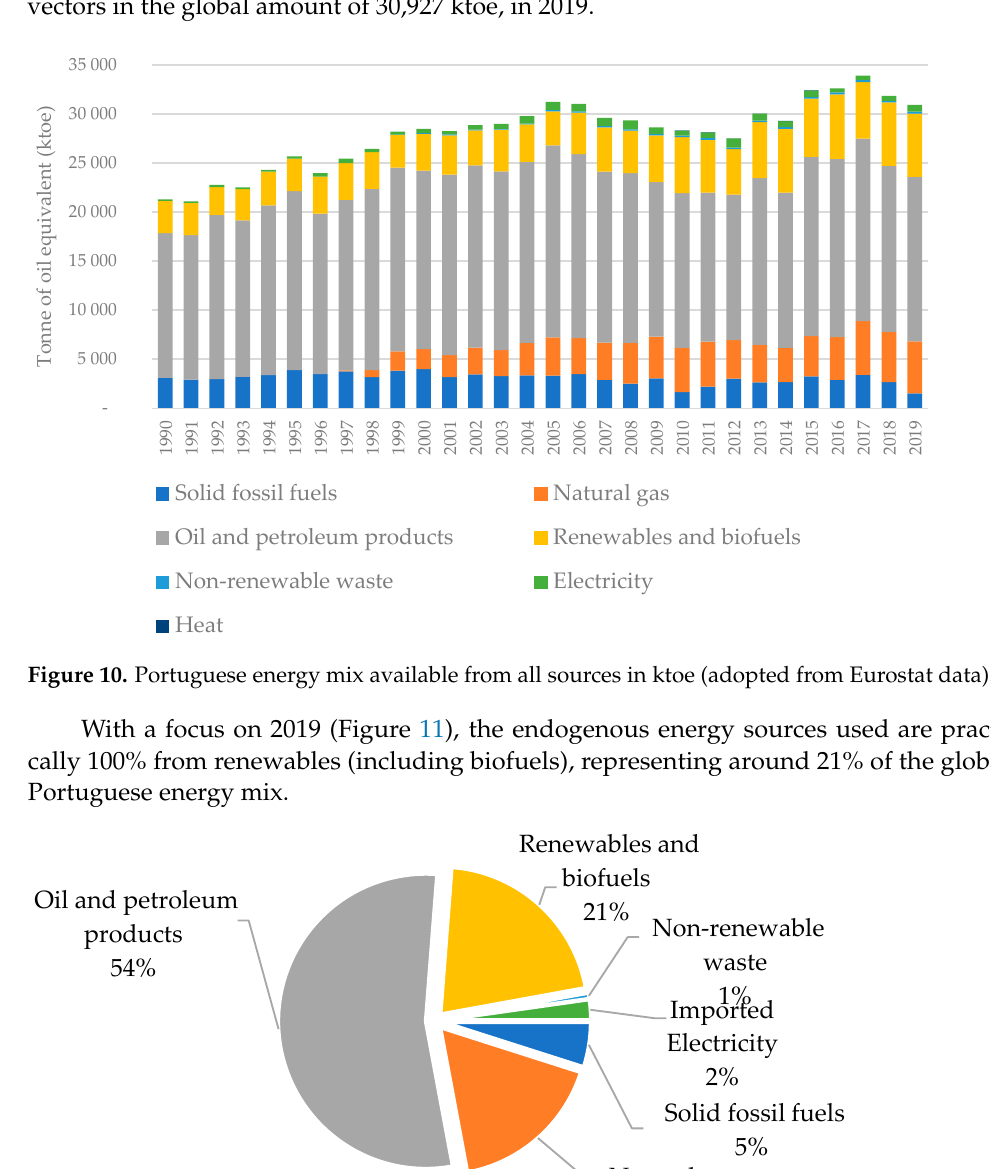
Figure 11. Portuguese energy mixes available in 2019 from all sources (adopted from Eurostat data). The energy vector oil and petroleum products (16,753 ktoe, 54%) can still be disaggregated as presented in Table 1, highlighting the weight of crude oil (68.5%), refined